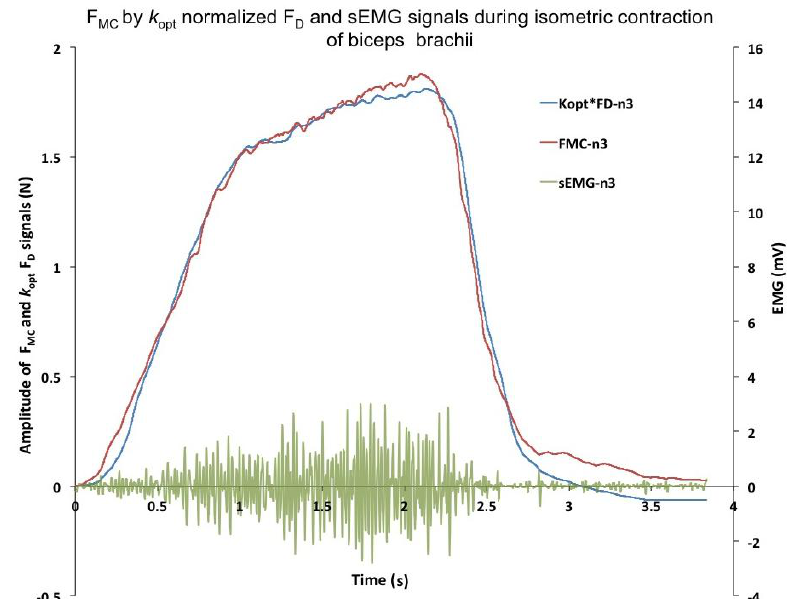
Figure 4. Simultaneously recorded F of biceps brachii muscle of subject 3 (n3). Coefficient sensitivity of the system k